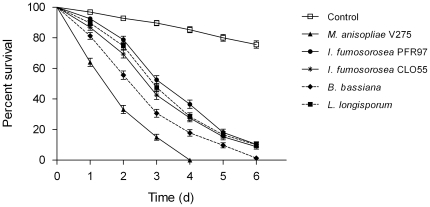
Effect of fungal infection on midge survival.Mean (± SEM) cumulative proportional survival of adult Culiocides nubeculosus exposed for 6 days to ‘dry’ conidia of entomopathogenic fungi Metarhizium anisopliae V275, Isaria fumosorosea PFR97, Isaria fumosorosea CLO55, Beauveria bassiana, Lecanicillium lecanii (1011 conidia m−2 on tissue paper) and uninfected control at 20±1°C. Controls were not exposed to any fungus (‘0’ dose). Data represent survival of eight replicates of approximately 40 adult males and females/replicates.